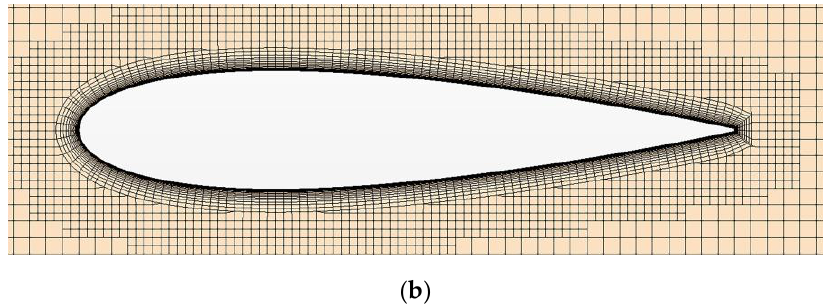
Figure 4. ( a ) Computational mesh of the domain; ( b ) computational mesh near the blade surface.